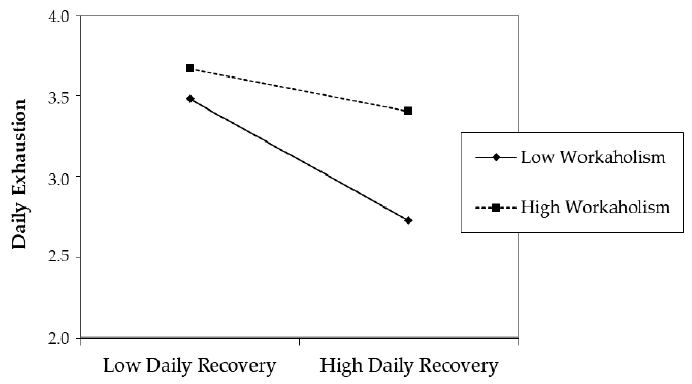
Figure 2. The interaction effect between general workaholism and daily recovery in the prediction of daily exhaustion.